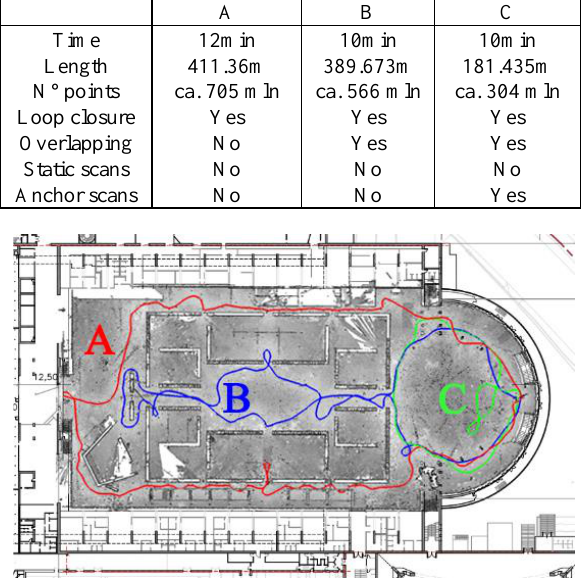
Figure 4. The three trajectories performed in the B Hall Here the reference dataset as ground-truth is a static Lidar acquisition. N°17 scans have been collected using a Faro Focus 3D X330 phase shift laser scanner: n°7 scans have been acquired in the first sector of the pavilion hallway, while n°10 scans have been acquired in the exedra apse. The point clouds have been